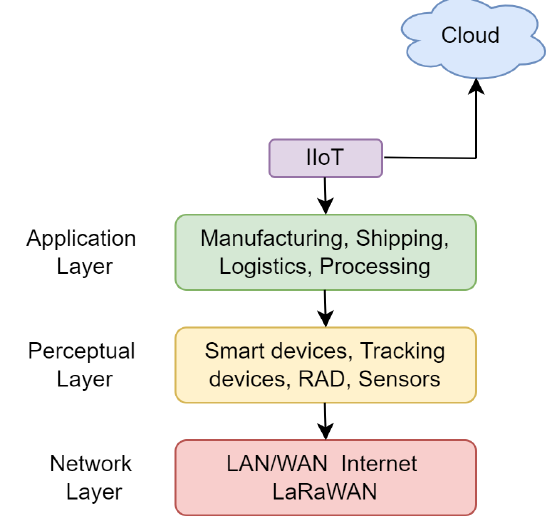
Figure 2. Proposed IDS Mechanism for